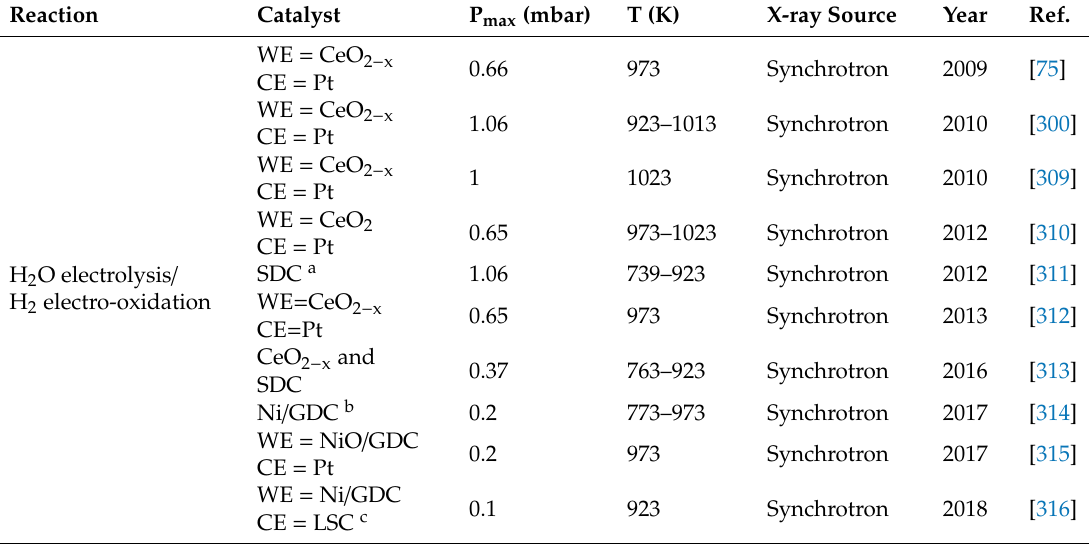
Table 2. Published NAP-XPS investigations of ceria-based catalysts in electrocatalytic reactions. Reaction Catalyst P max (mbar) Ref.